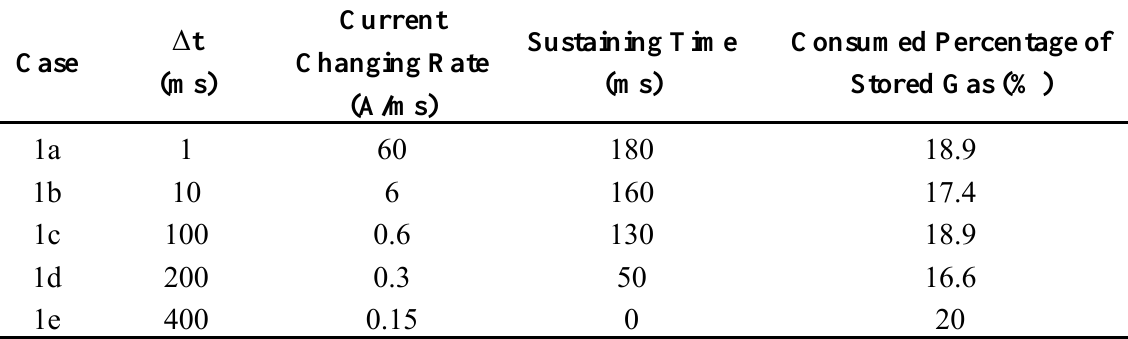
Table 1. Variations of Δ t, sustaining time and consumed percentage of stored